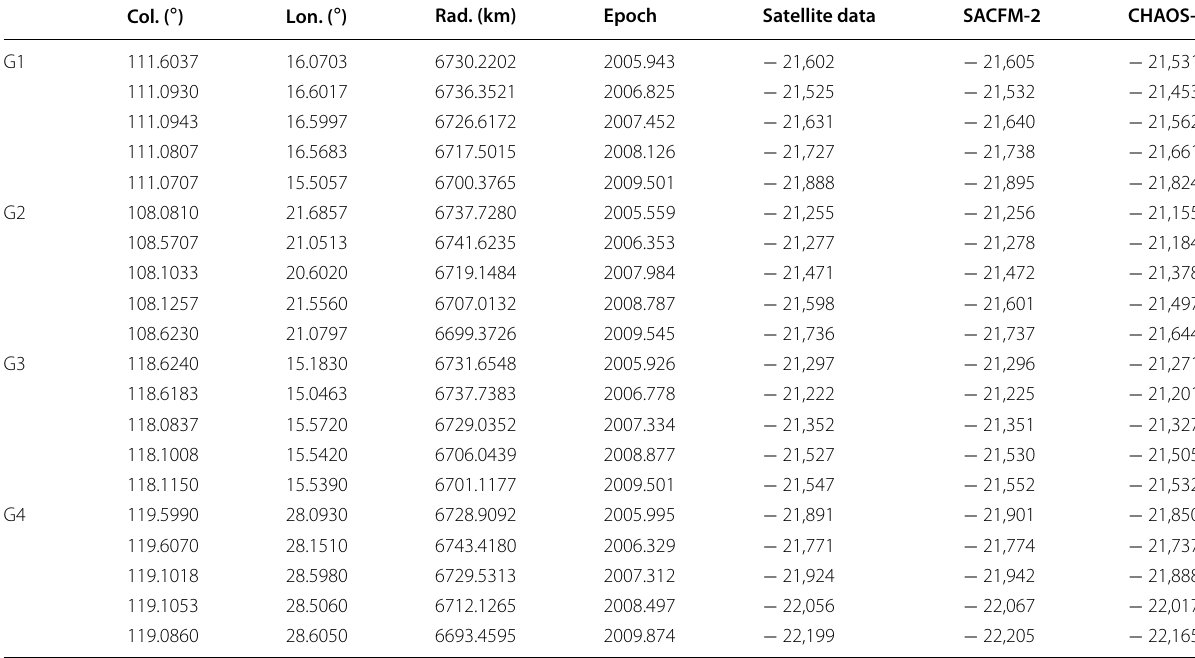
The Z component values are in nT